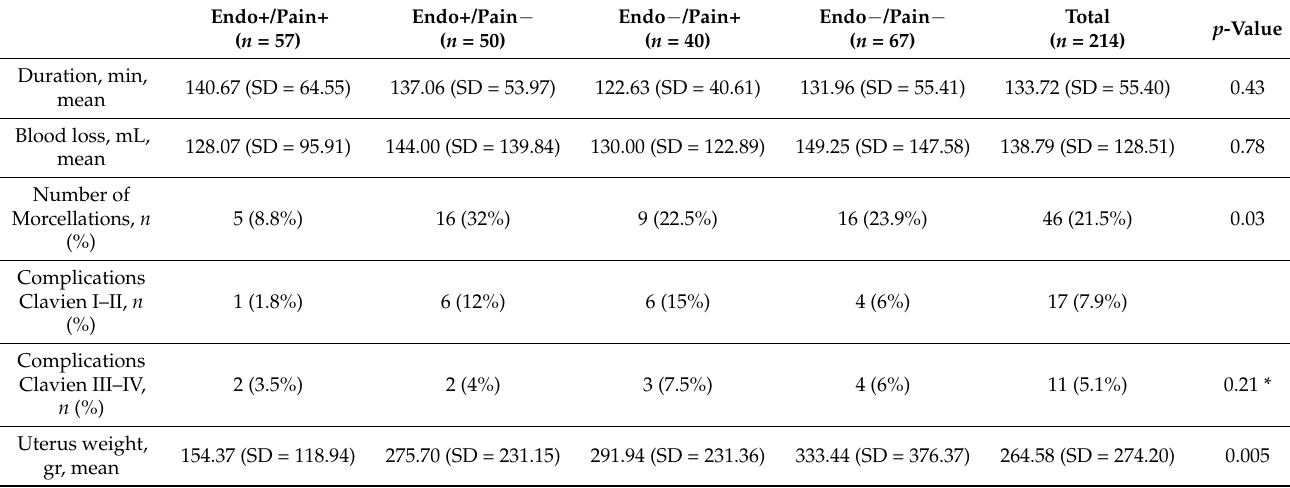
Table 2. Surgical